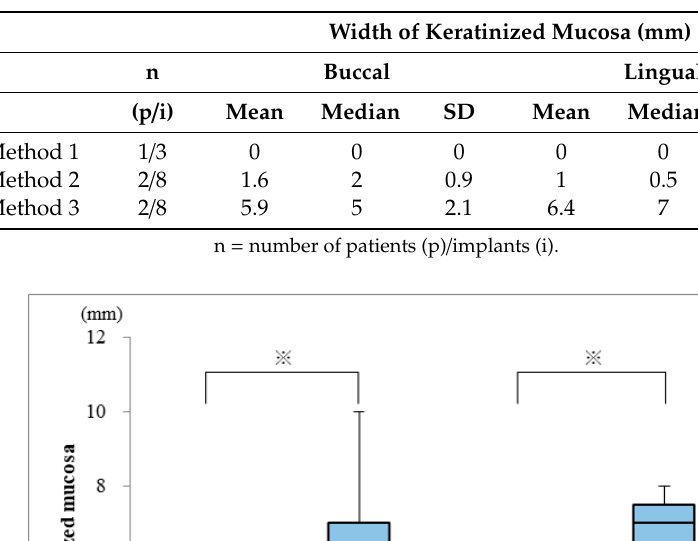
Figure 6. Clinical photograph of postoperative FGG. ( A ): Method 1 (Case 1), ( B ): Method 2 (Case 3), ( C ): Method 3 (Case 5). Method 3 showed the largest (significantly) keratinized mucosa width on both the buccal and lingual sides. Table 2. Keratinized mucosa width measurements for Methods 1–3.